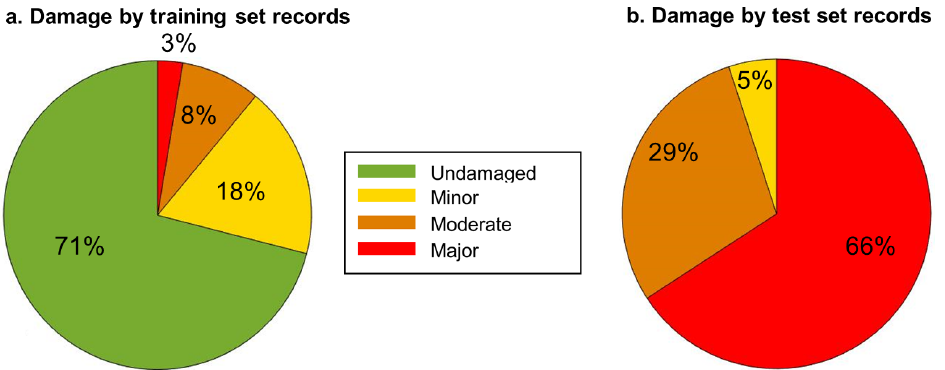
Figure 4. Damage states of the SDOF system produced by records from ( a ) Set-1 and ( b )